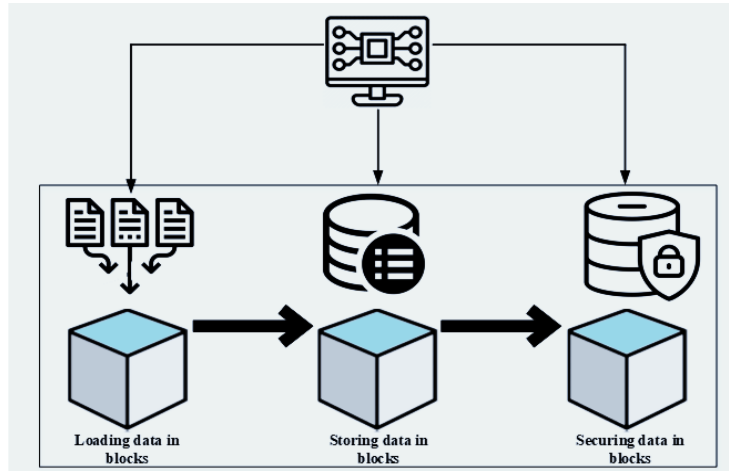
Figure 6. Storage and security of block information.